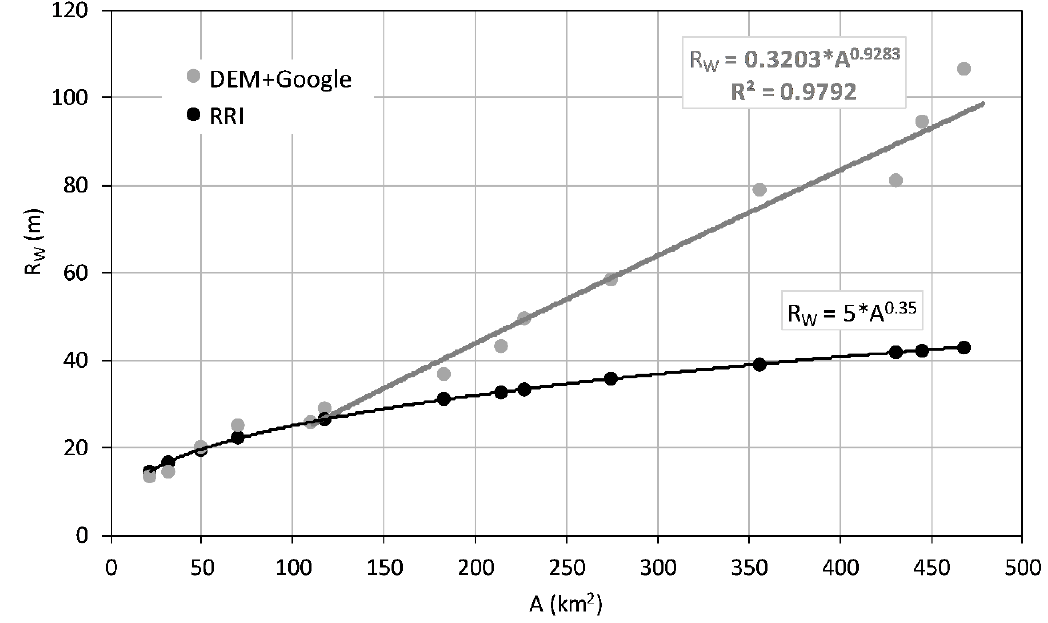
Figure 3. The relationship between the river basin area (A) and river width (Rw) for the Oda river basin. Black and gray points with fitted black and gray lines indicate the default Rw-A relationship based on the Rainfall-Runoff-Inundation (RRI) model and digital elevation model (DEM)/Google Earth data, respectively.